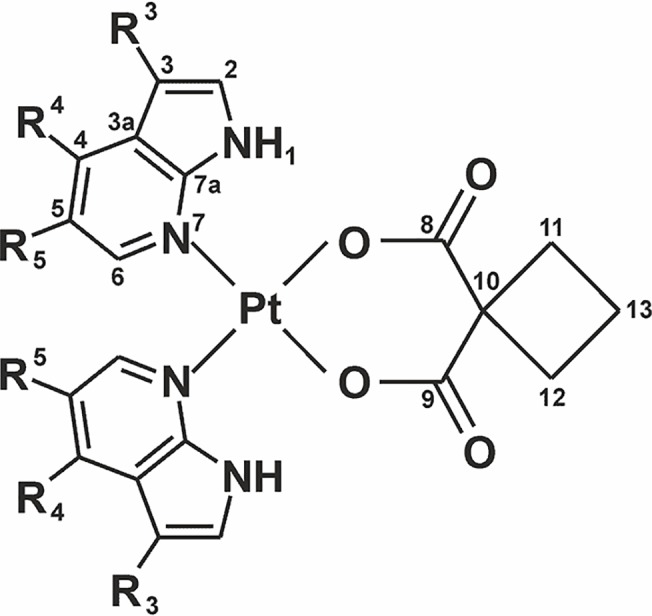
Structural formula of the studied complexes [Pt(cbdc)(naza)2] (1–6).The formula is given together with their atom numbering scheme; R3, R4, R5 = Cl, H, H (3-chloro-7-azaindole (3Claza), involved in complex 1); Br, H, H (3-bromo-7-azaindole (3Braza), 2); I, H, H (3-iodo-7-azaidole (3Iaza), 3); H, Cl, H (4-chloro-7-azaindole (4Claza), 4); H, Br, H (4-bromo-7-azaindole (4Braza), 5); and H, H, Br (5-bromo-7-azaindole (5Braza), 6).